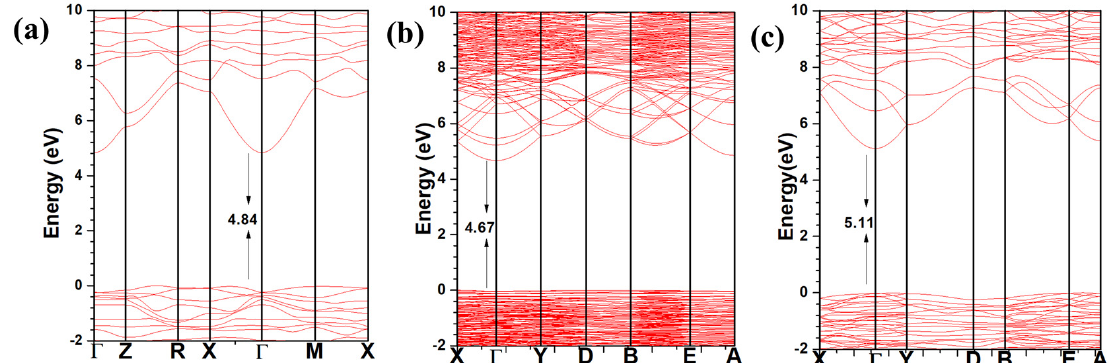
Figure 2. Shows band structures for ( a ) kaolinite, ( b ) muscovite, and ( c ) montmorillonite. Muscovite and MMT show a direct bandgap, whereas kaolinite shows an indirect bandgap.